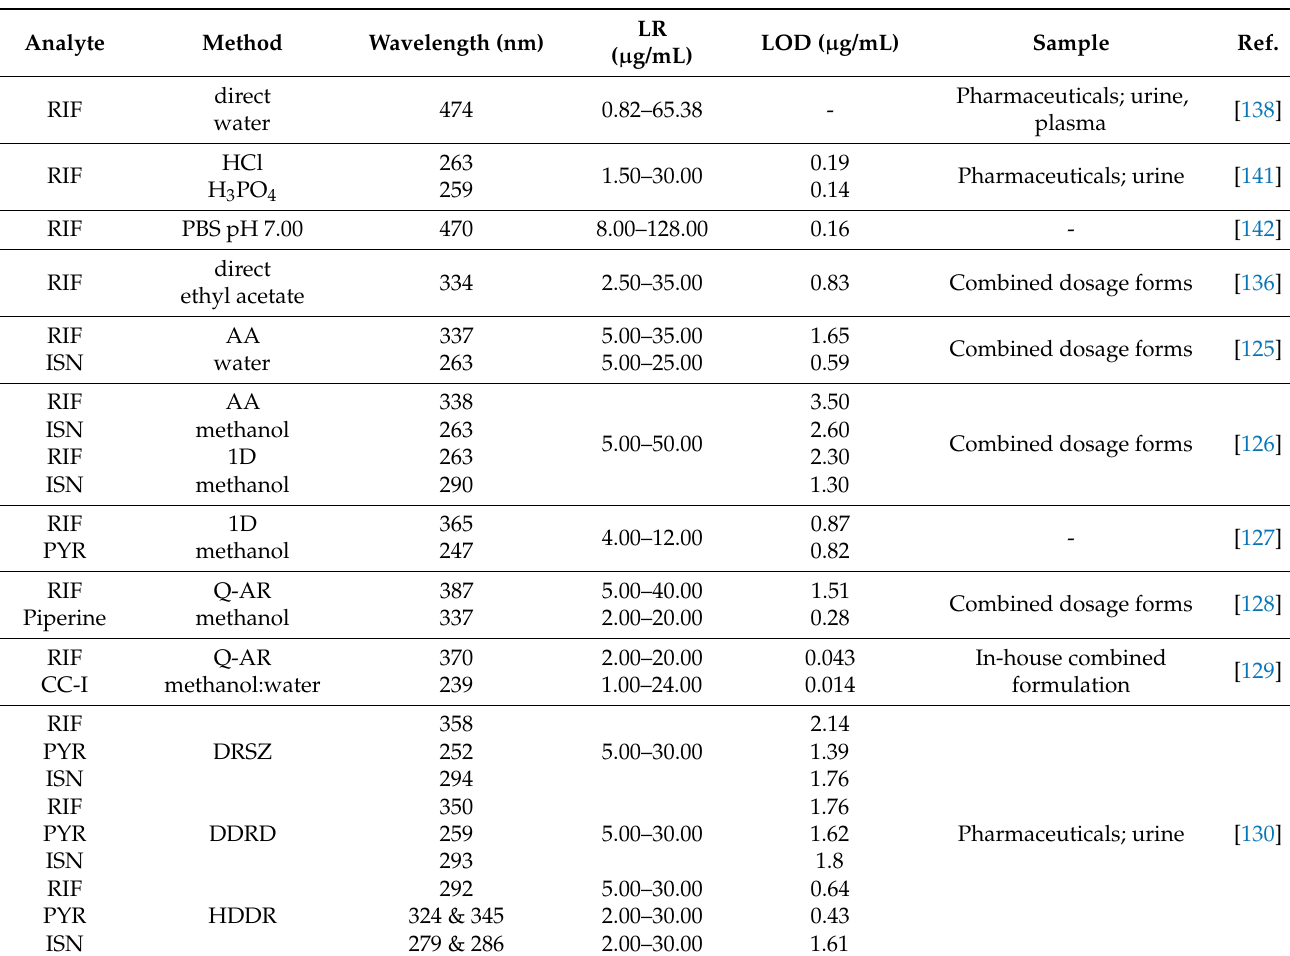
Table 2. The performance characteristics of spectrometric methods reported in the literature for rifamycins